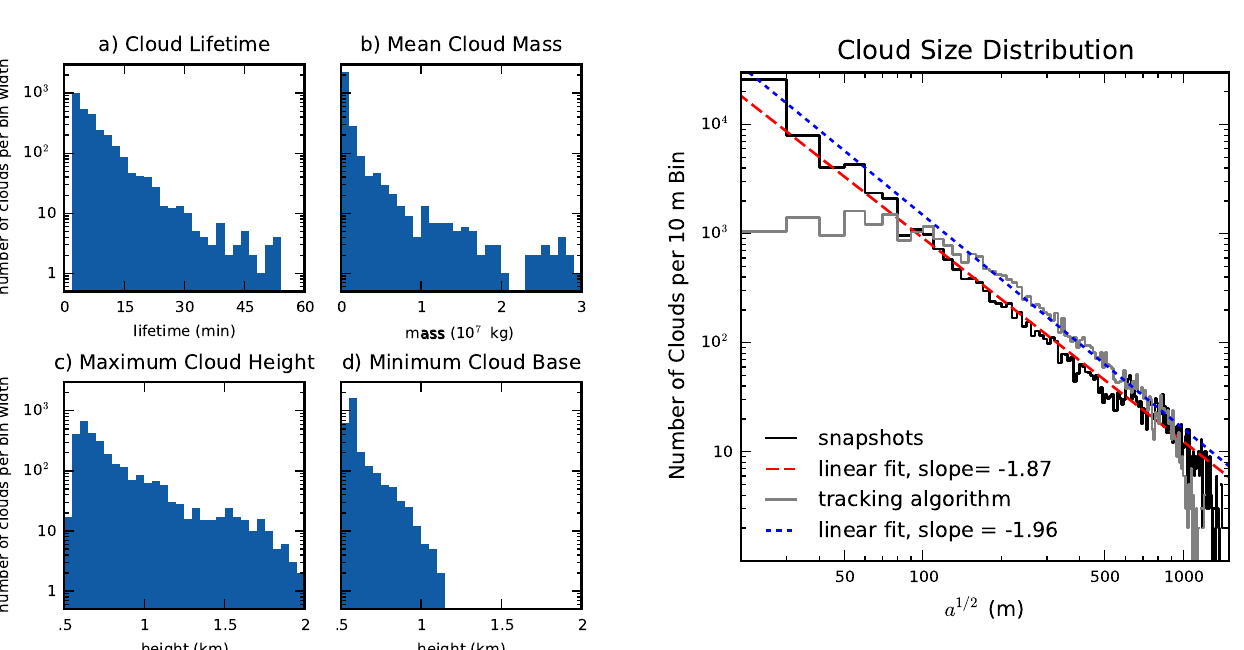
Fig. 7. Histograms of horizontal cloud length scales calculated from instantaneous cloud field snapshots (black line) and from the cloud tracking algorithm (grey line) using a 10m bin width. The red dashed line and blue dotted line show linear best fit between 100–1000m length scales to the instantaneous and tracked cloud histograms,